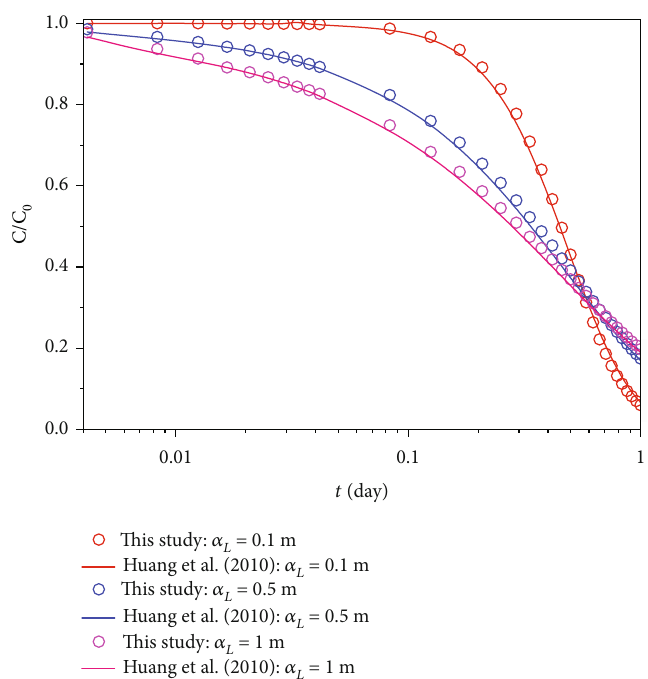
Figure 3: Comparison between the numerical solutions of this study and the analytical solutions of Huang et al.